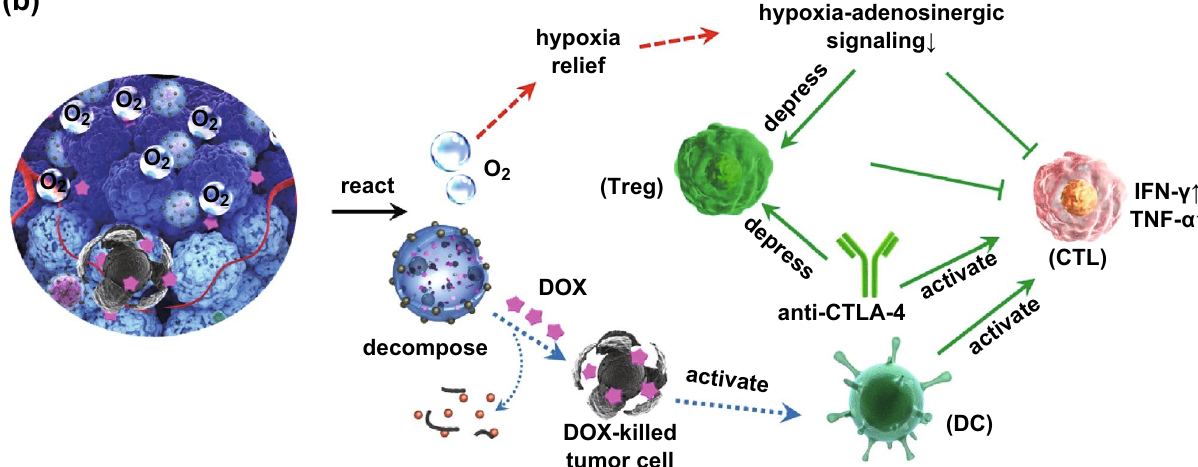
Scheme 1 a Schematic illustration of the proposed roles of CDSDM NRs in tumor hypoxia relief. b The proposed mechanism and reaction pathways include the relief of hypoxia‑induced immunosuppression (red dashed arrows), the DOX‑mediated chemotherapy and immune activa‑ tion (blue dotted arrows), and the synergistic actions between them and the CTLA‑4 blockade (green arrows). (Color figure